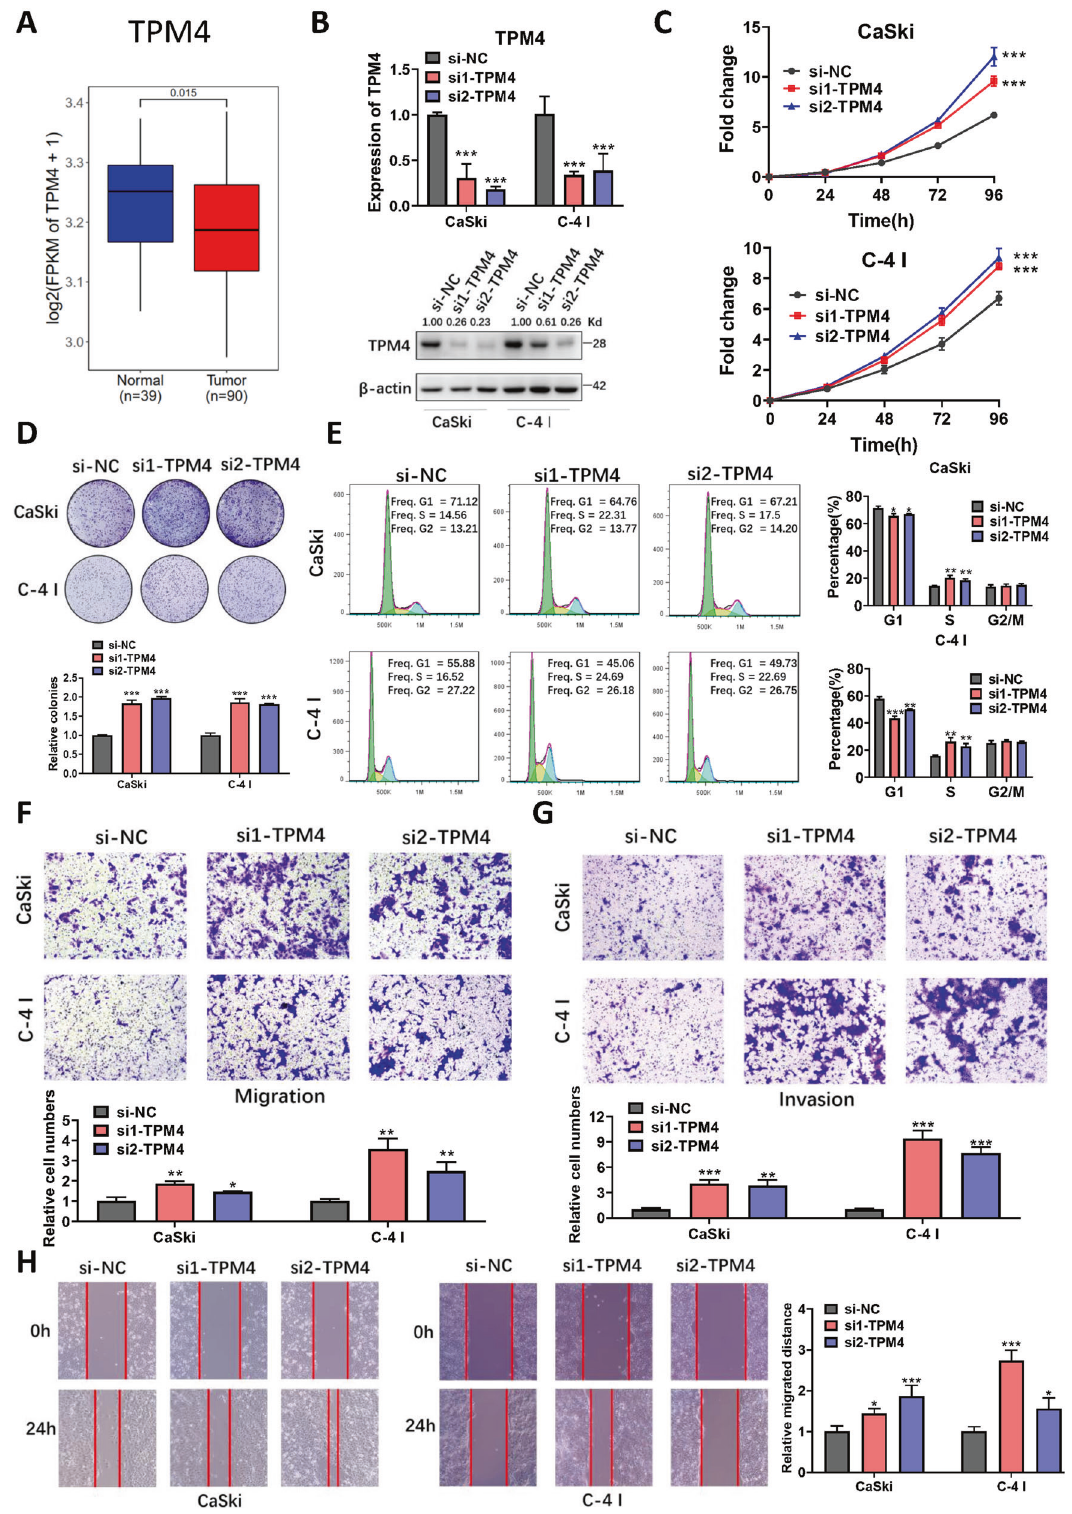
Fig. 6 TPM4 inhibits cervical cancer cell proliferation, migration, and invasion in vitro. A TPM4 expression in cervical cancer from RNA-seq data. B Relative expression of TPM4 in cervical cancer cells transfected with siRNA as determined by qRT-PCR and western blot. C Proliferation of cervical cancer cells transfected with TPM4 siRNA as assessed by CCK8 assay. D Clonogenic assays of cervical cancer cells transfected with TPM4 siRNA. E Flow cytometry analysis of cell cycles of cells transfected with TPM4 siRNA. F , G Migration and invasion of cervical cancer cells transfected with TPM4 siRNA, assessed by transwell assays. H Wound healing assays of cervical cancer cells transfected with TPM4 siRNA. Data are shown as mean ± SEM. * P < 0.05; ** P < 0.01; *** P < 0.001.